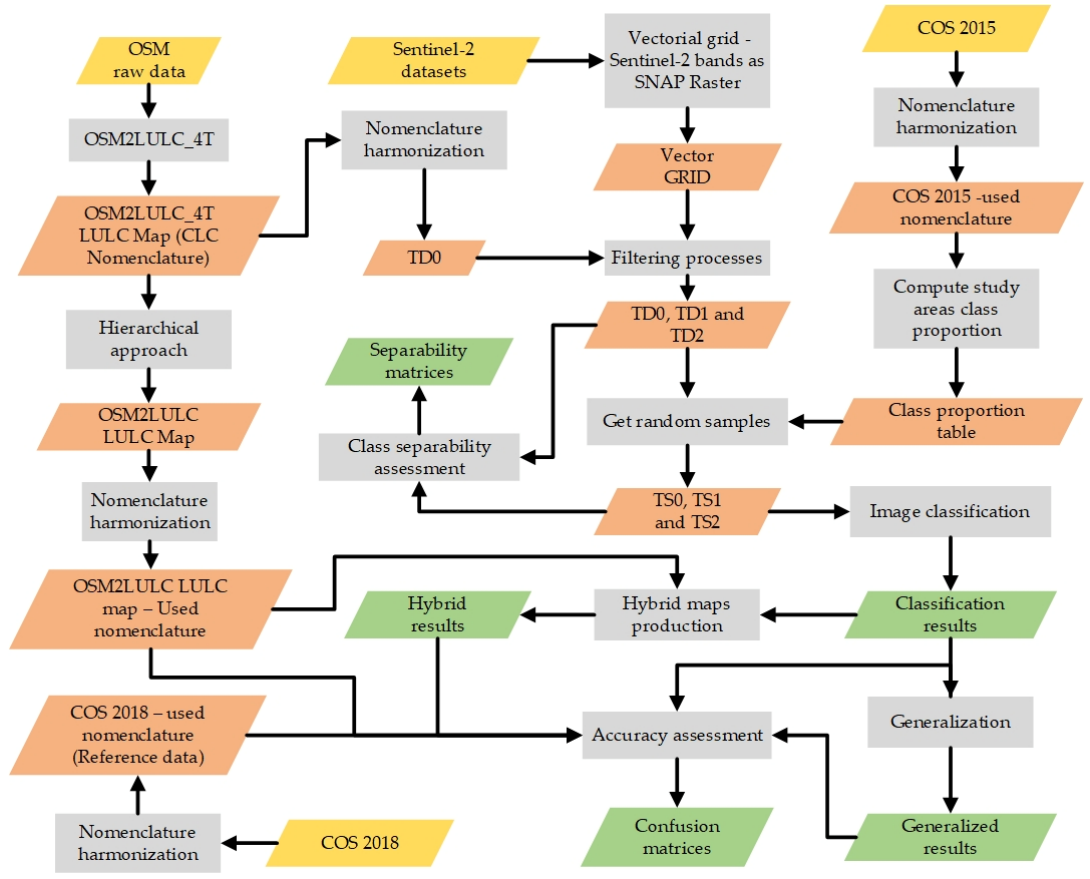
Figure 3. Methodology workflow.